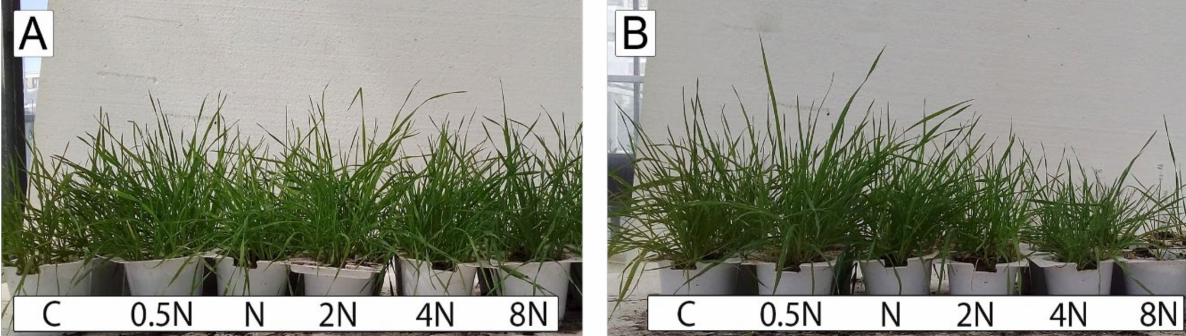
Figure 4. A. spica-venti population APSII seedlings sprayed with fenoxaprop-P-ethyl ( A ) and pinox- aden ( B ) at doses of 0.5 N, N, 2 N, 4 N and 8 N. C: untreated control.